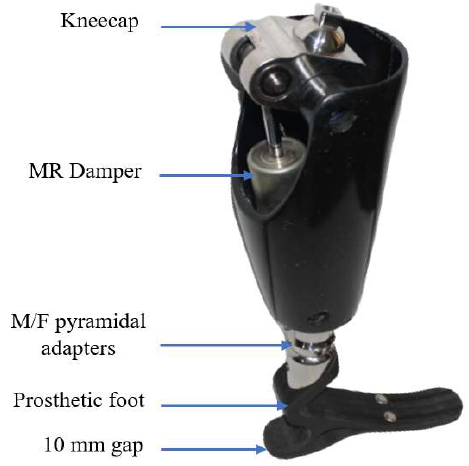
Figure 15. Rear view of the built prosthetic leg.